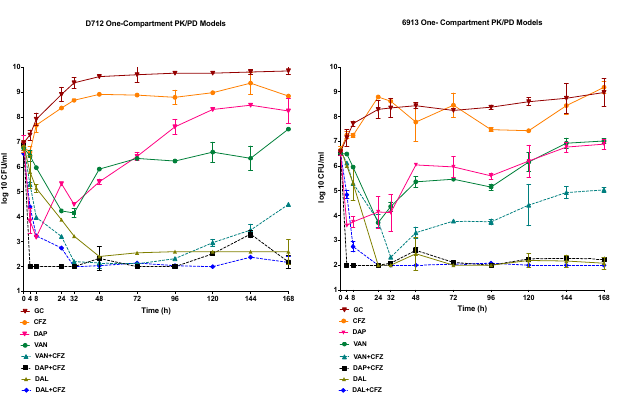
Figure 2. One-compartment PK/PD, 168-h models, completed on the 2 DNS-VISA strains (D712 and 6913), evaluating DAL, VAN, DAP alone and in combination with CFZ.